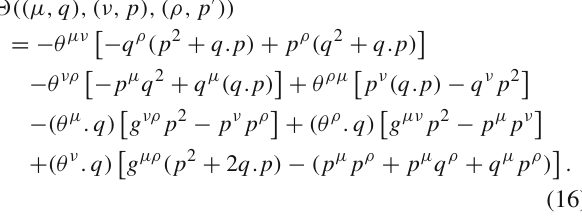
(see Eq. (4)), considering the N = − 2 S in 2 θ w K γ gg is writ-